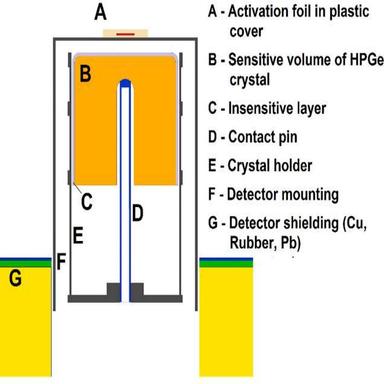
Cut in central midplane with schematic visualization of angles to the activation foils. The activation foils are visualized with various colors, but it is just for highlighting different positions.